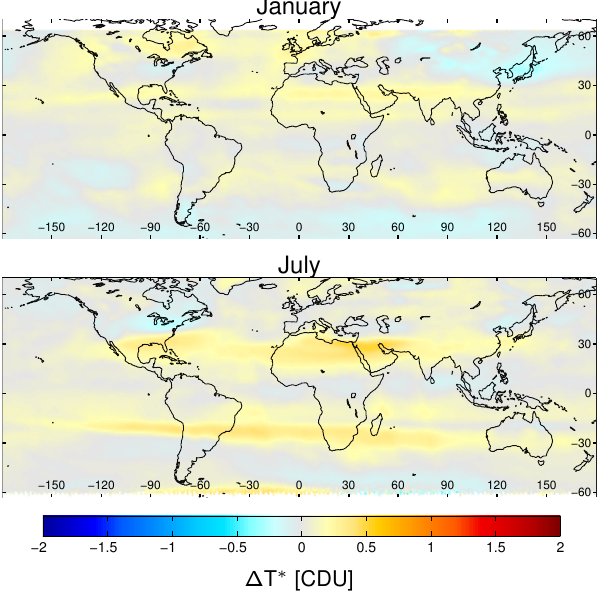
Figure 10. Monthly mean difference of tropospheric residues T ∗ from NASA and STREAM for OMI measurements in January (top) and July (bottom) 2005.